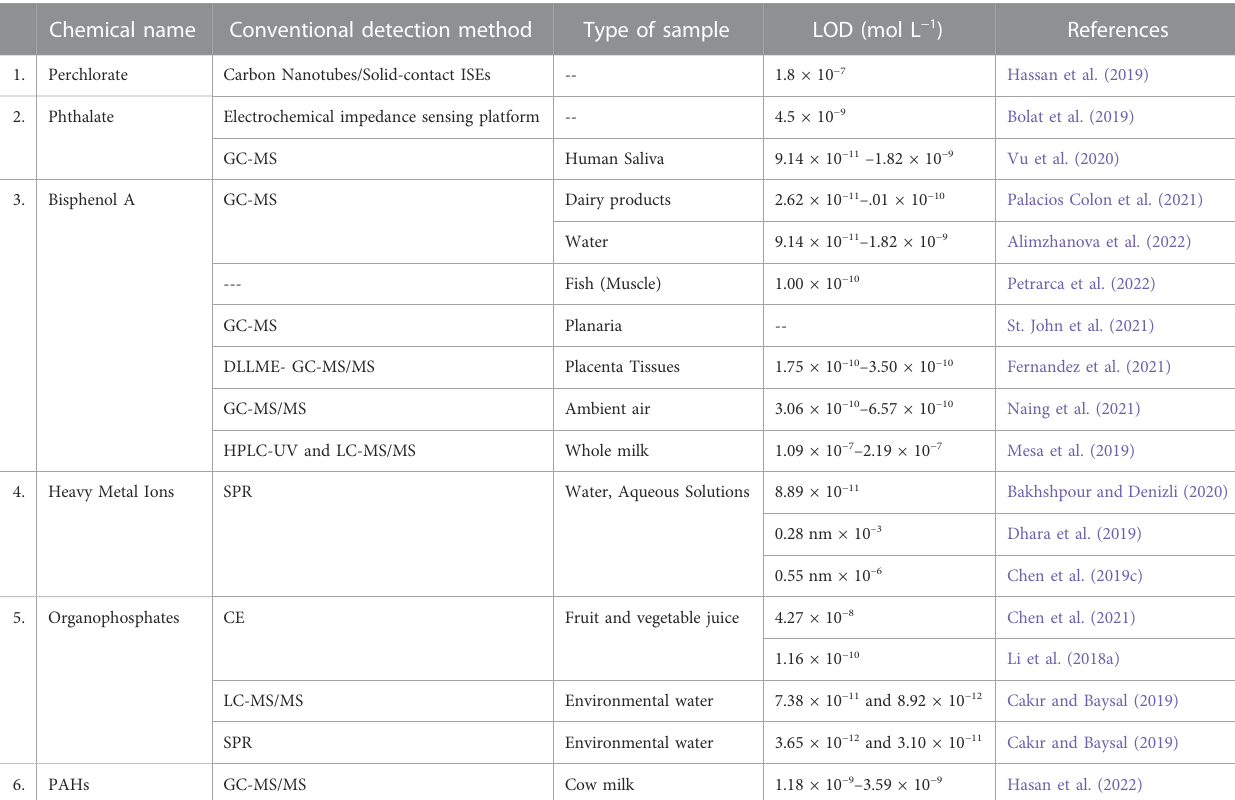
TABLE 1 Instrument-based techniques for monitoring EDCs in selected